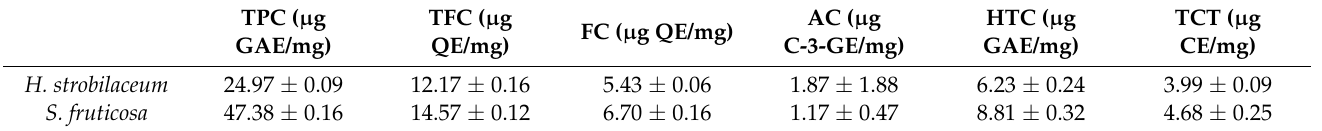
Table 4. Content of phenolic compounds in the hydro-methanolic extracts from the aerial part of H. strobilaceum and S. fruticosa